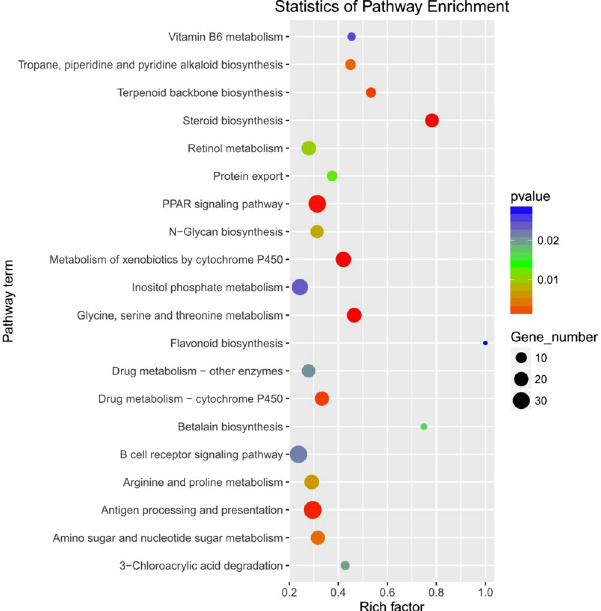
Figure 4. KEGG pathway enrichment analysis of the differentially expressed mRNAs from the liver of GIFT exposed to 37.5 °C